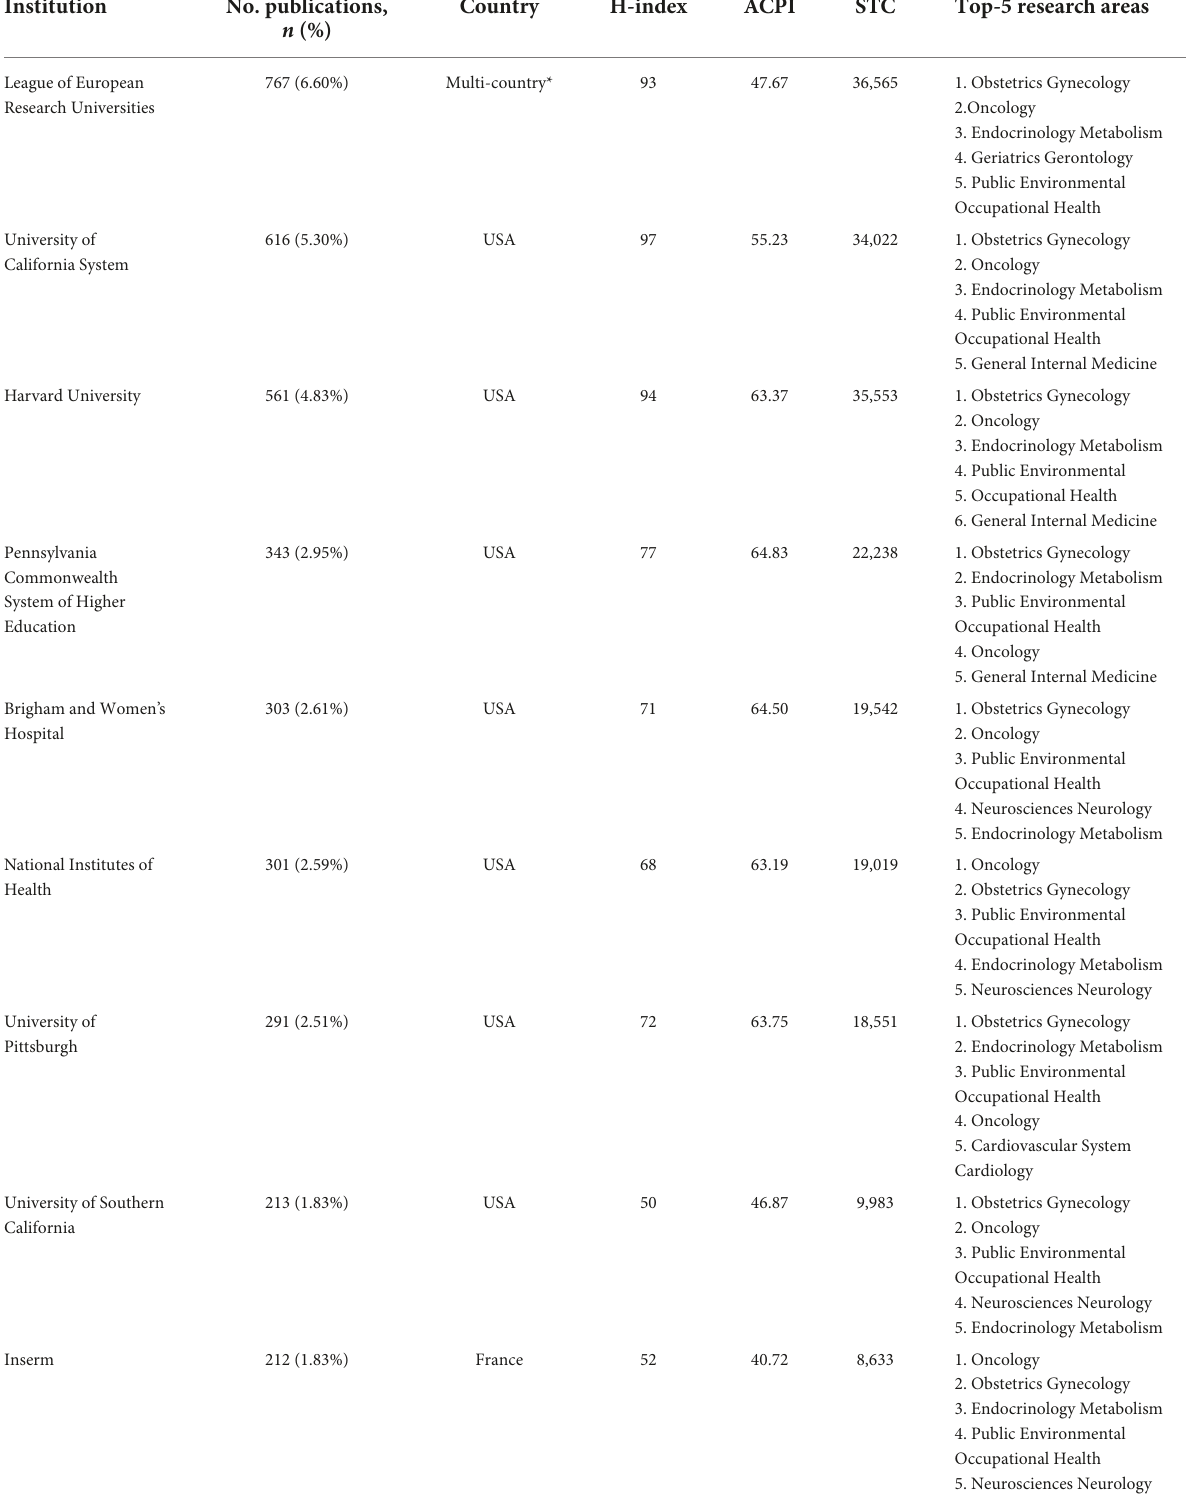
TABLE 3 Institutions having more than 200 menopausal hormone therapy (MHT)-related publications ( N = 11,616).